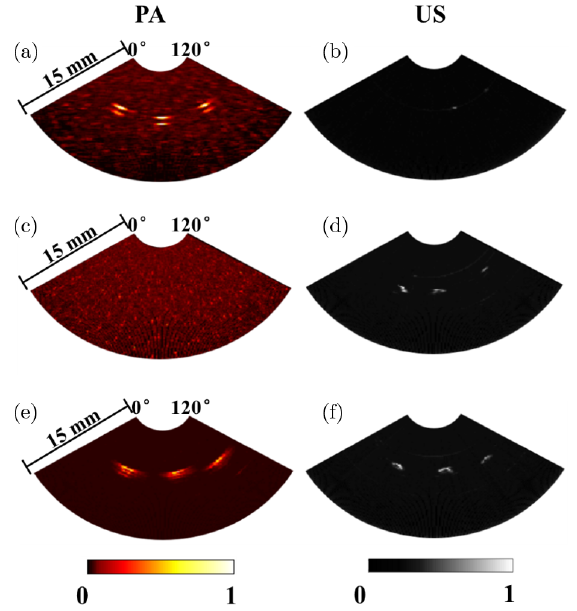
Fig. 3. PA and ultrasonic B-scan images of tissue mimicking phantoms. (a) and (b) The ¯rst group of targets with an optical contrast and no acoustic contrast. (c) and (d) The second group of targets with an acoustic contrast and no optical contrast. (e) and (f) The third group of targets with both optical and acoustic contrasts.